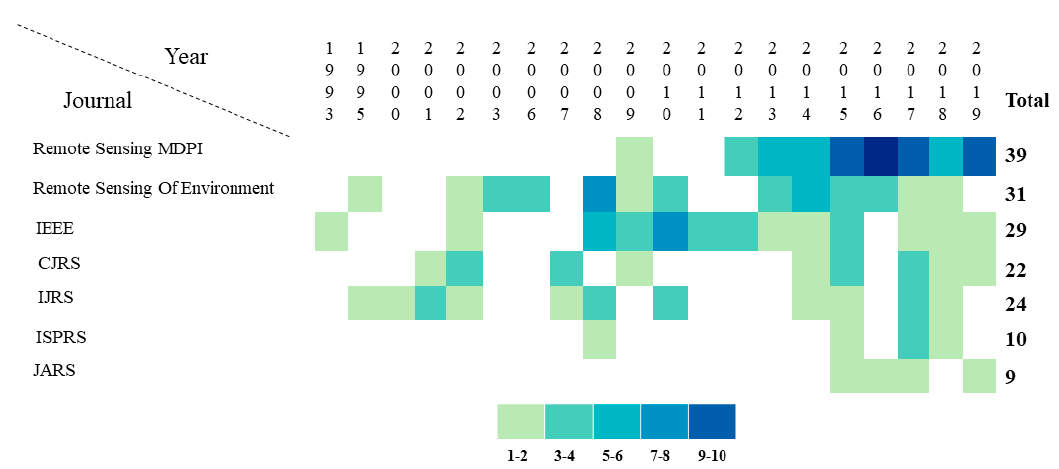
Figure 4. Count of papers published in seven leading remote sensing journals from 1993 to 2019: Remote Sensing MDPI, Remote Sensing of Environment (RSE), IEEE Transactions on Geoscience and Remote Sensing, Canadian Journal of Remote Sensing (CJRS), International Journal of Remote Sensing (IJRS), International Society for Photogrammetry and Remote Sensing (ISPRS) Journal and Journal of Applied Remote Sensing (JARS).